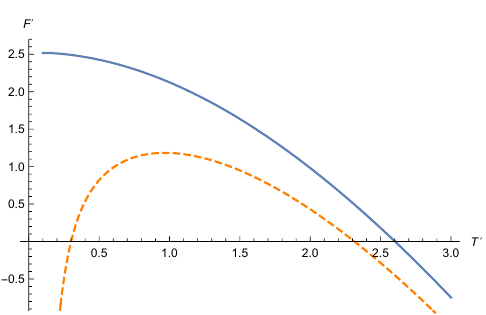
Figure 3. Plot of the free energy in the low temperature approximation. The blue solid curve is the quenched free energy in the low temperature approximation while the orange dashed curve is the all-genus result of the annealed free